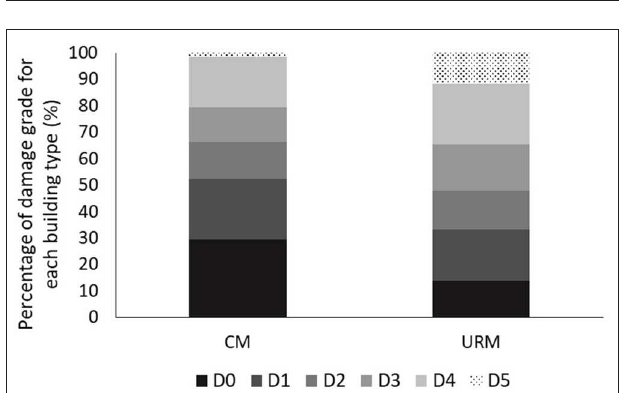
FIGURE 3 | Cumulative percentage of URM and CM buildings as a function of damage level (D) (original).